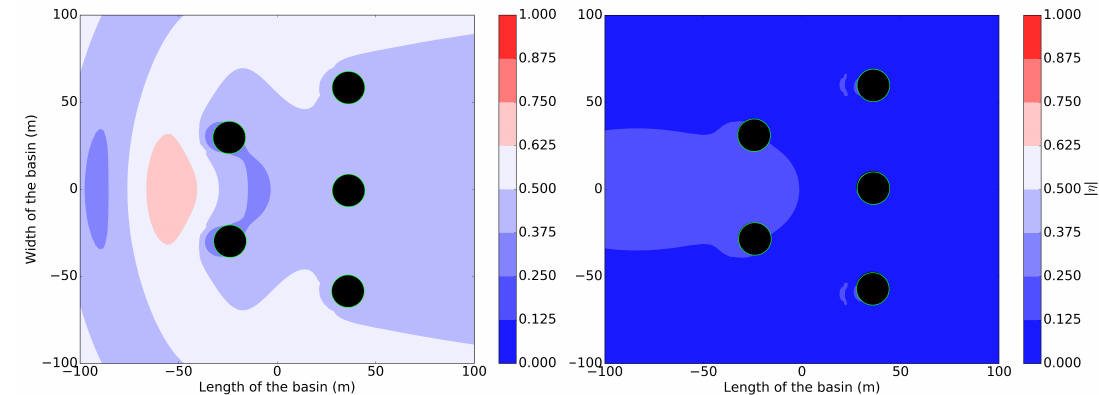
Figure 16. The total ( left ) and perturbed ( right ) | η | for a heaving cylindrical WEC for a wave of H = 1.0 m, T = 10.0 s for a linear PTO system. Incident wave propagating from the left.